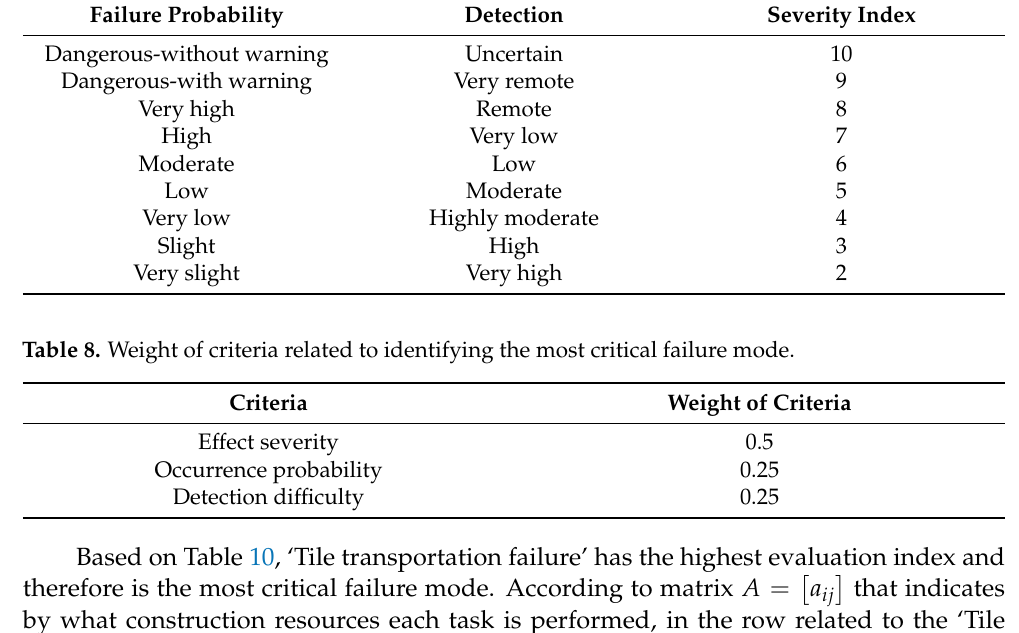
4 Table 10. Evaluation index for each failure mode. Failure Mode